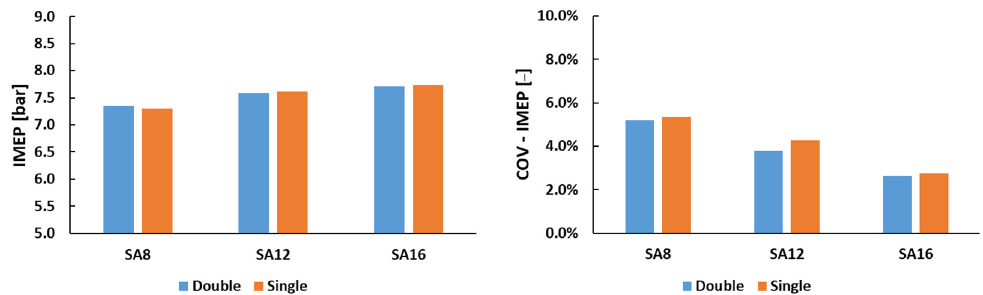
Figure 8. IMEP and COV IMEP for both spark plug electrode designs and cross-flow orientation (AFR rel 1.15, SA 8–12–16 CAD).